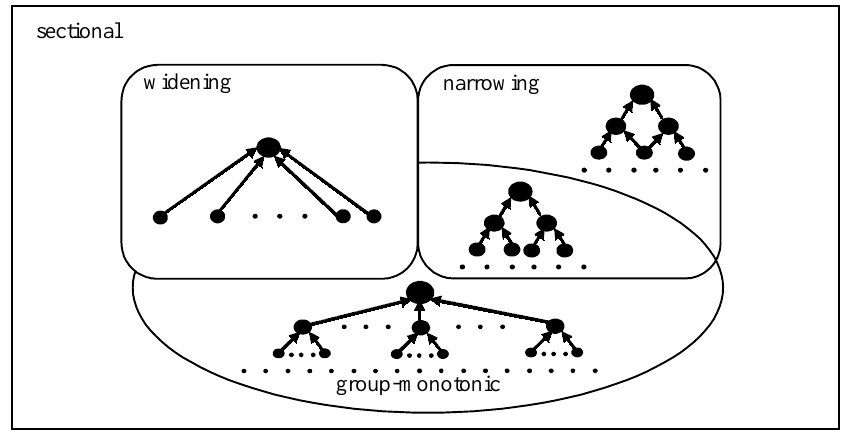
Fig 7. Interrelationship between classes of group-monotonic, narrowing and widening cost